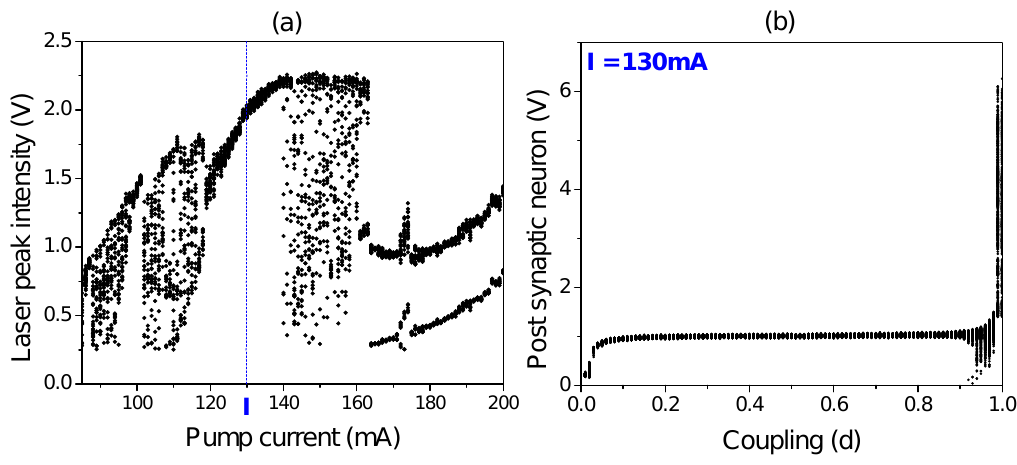
Figure 7. Bifurcation diagrams of ( a ) laser peak intensity and ( b ) post-synaptic neuron peak